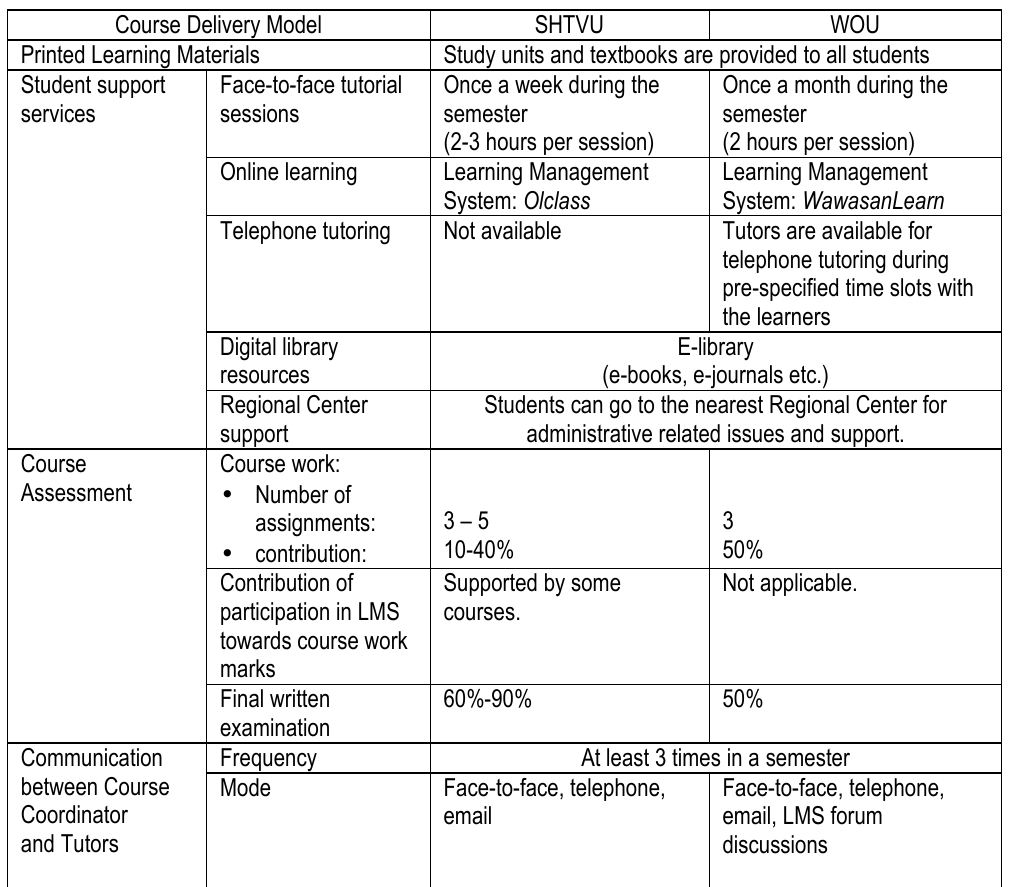
Table 1. Course Delivery Model of SHTVU and